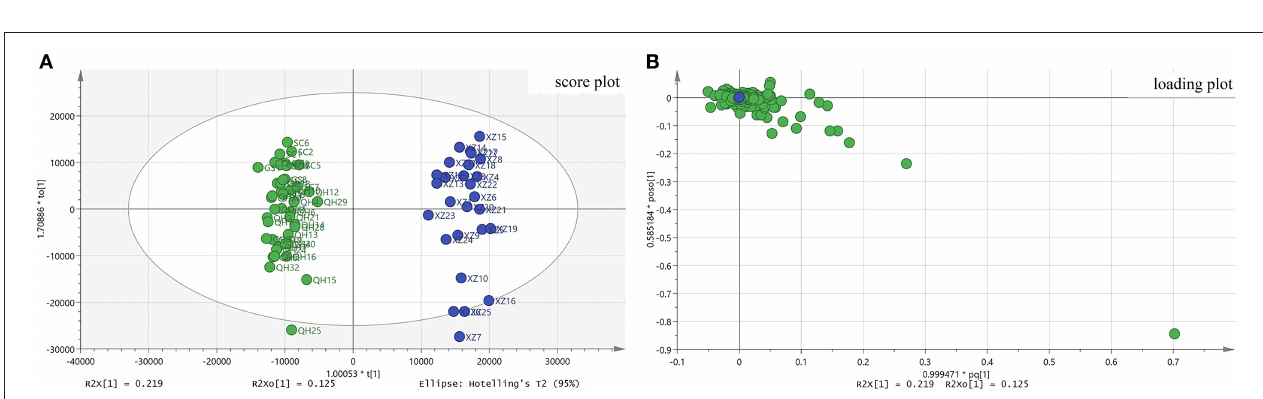
FIGURE 4 | OPLS-DA results of A. tanguticus . Score plot from OPLS-DA (A) , Loading plot from OPLS-DA (B)